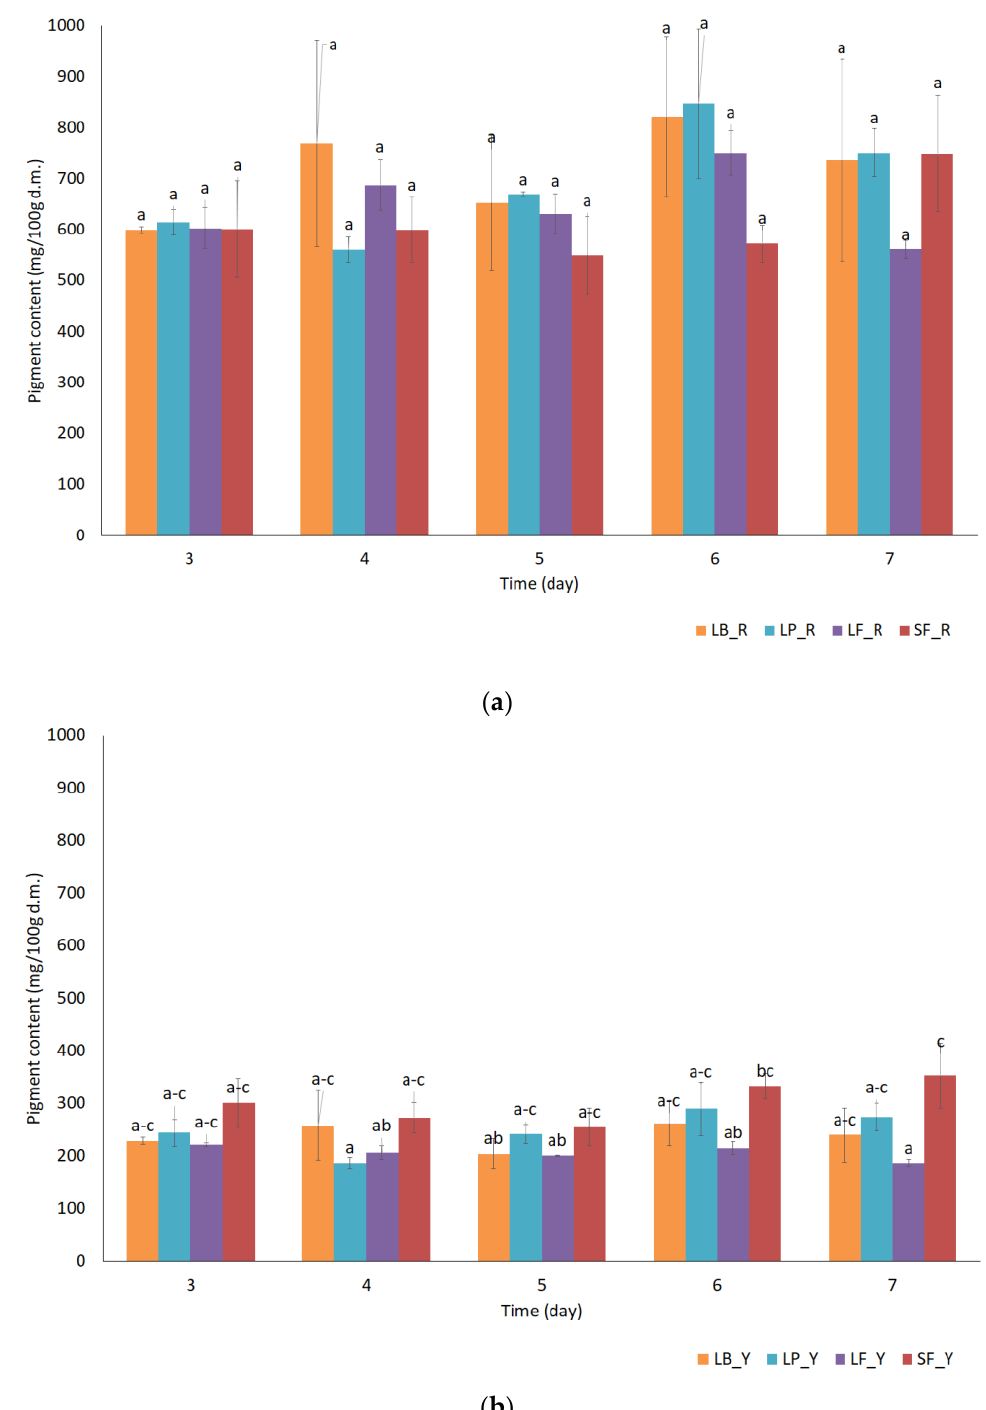
Figure 1. Content of betalain pigments during 7 days of juice fermentation ( a ) red pigment content ( b ) yellow pigment content, SF—spontaneous fermentation, LB— Levilactobacillus brevis , LF— Limosilactobacillus fermentum , LP— Lactiplantibacillus plantarum , _R, _Y—mean red pigment or yellow pigment, respectively, and a, b, c, and other letters—different indexes for pigment mean statistically significant differences for given values at the level of p <